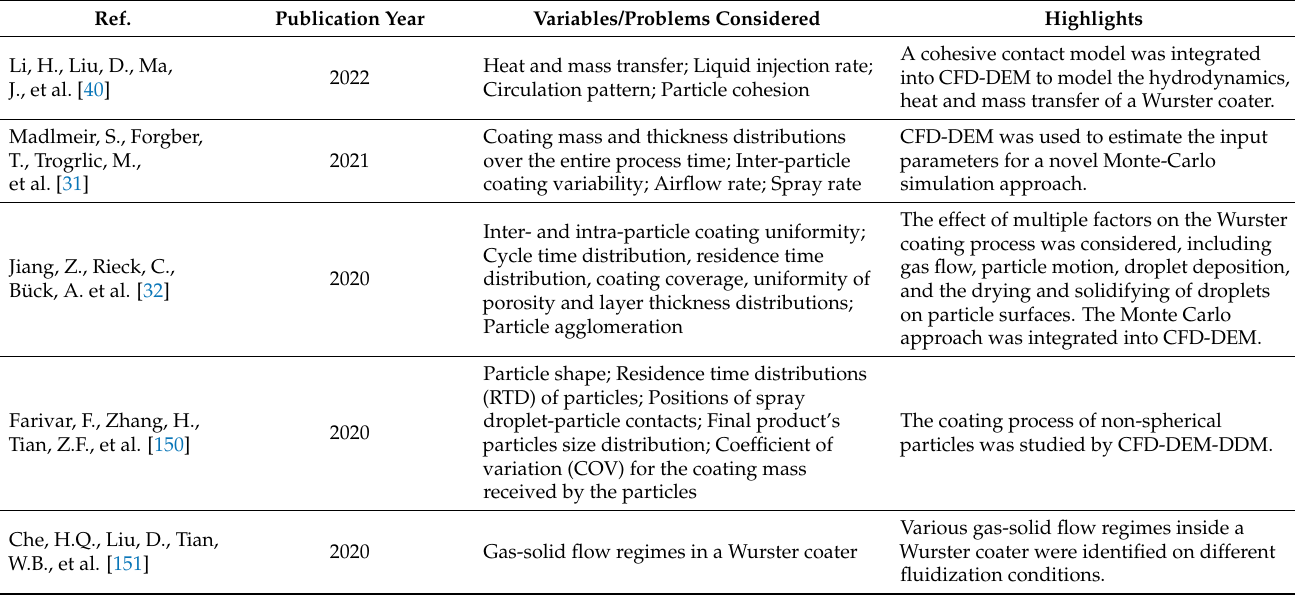
Table 2. Representative modeling studies of wet fluidized bed granulators and coaters using CFD-